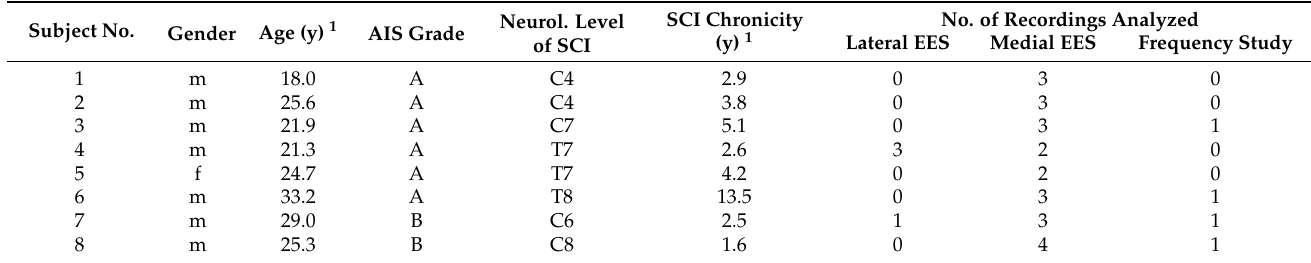
Table 1. Clinical characteristics of subject population and number of EMG recordings analyzed. Subject